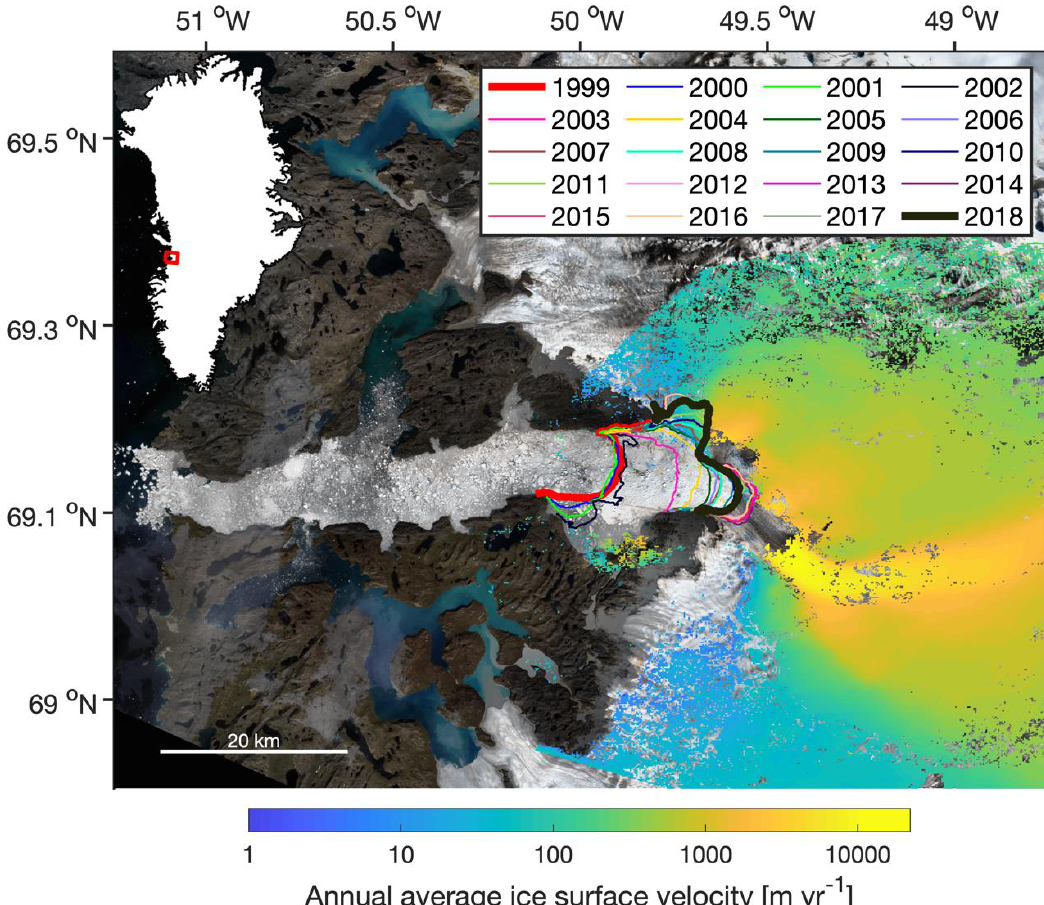
Figure 6. The largest single contributor of ice discharge 𝐷 from the Greenland Ice Sheet to the global ocean during recent decades is Sermeq Kujalleq (Jakobshavn Isbræ ), shown here in a 27 July 2017 Landsat 8 Operational Land Imager 30 m resolution image (RGB: band 4 (red), 3 (green), and 2 (blue)). The annual average ice surface velocity for the period 2011 – 2016 is shown for upstream areas, calculated from Landsat-8 (optical), Sentinel-1, and RADARSAT-2 (interferometric SAR) image processing [212]. The maximum surface velocity value is ~12 km yr −1 . Calving fronts, which mark the terminus position of the outlet glacier where ice is discharged to the ocean, are mapped from Landsat-7, Landat-8, and Sentinel-2B optical imagery [229]. Sermeq Kujalleq has lost 137 km 2 of surface area between 1998 – 2018 (compare thick red line to thick black line), resulting in near-complete disintegration of its floating ice tongue [224,227]. Its flow speed has nearly doubled since the early 1990s, with upstream thinning rates exceeding 15 m yr −1 [226]. Inset is the Greenland Ice Mapping Project (GIMP) ice mask [185] with the red box showing the extent of the image area.